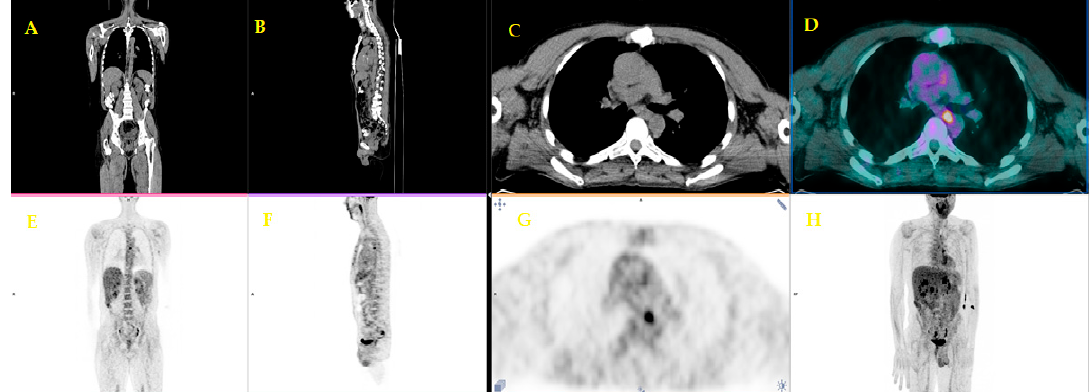
Figure 5. Lymph-nodal uptake suggestive of metastasis in the same patient (Images from Nuclear Medicine Unit, Padova University Hospital). Legend: A = Coronal image of low-dose CT; B = Sagittal image of low-dose CT; C = Axial image of low-dose CT; D = PET/CT fused image; E = Coronal image of PET; F = Sagittal image of PET; G = Axial image of PET; H = Maximum intensity Projection (MIP).